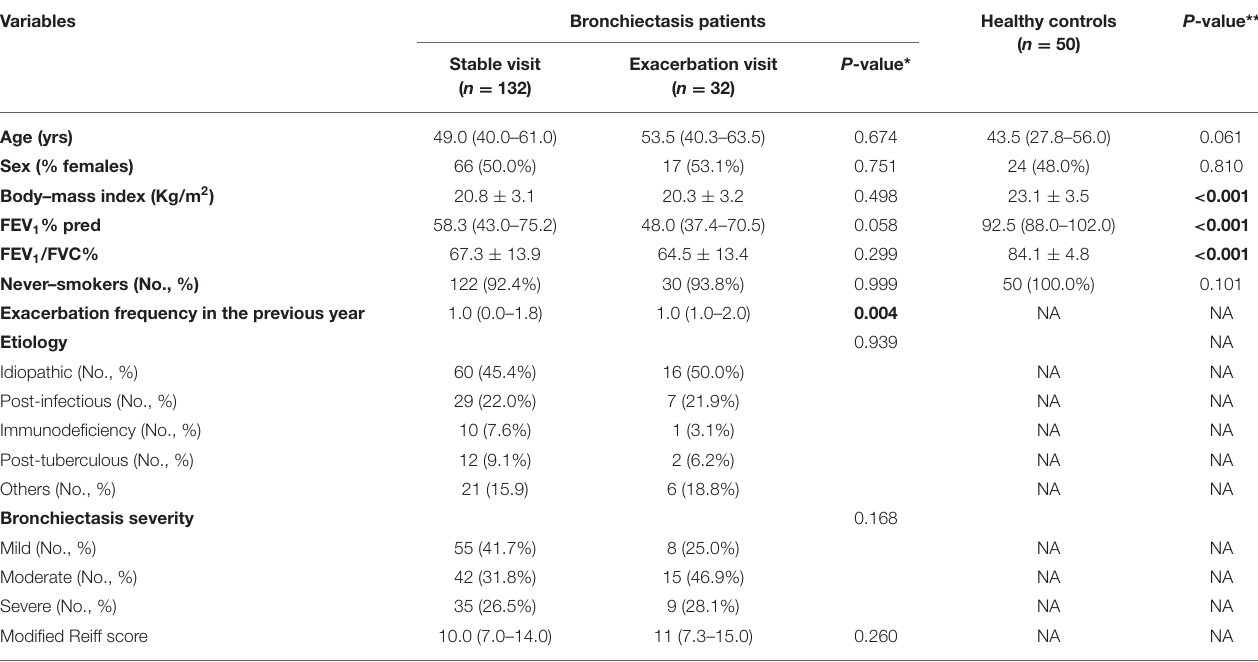
TABLE 1 | Baseline characteristics of patients with bronchiectasis and healthy controls.